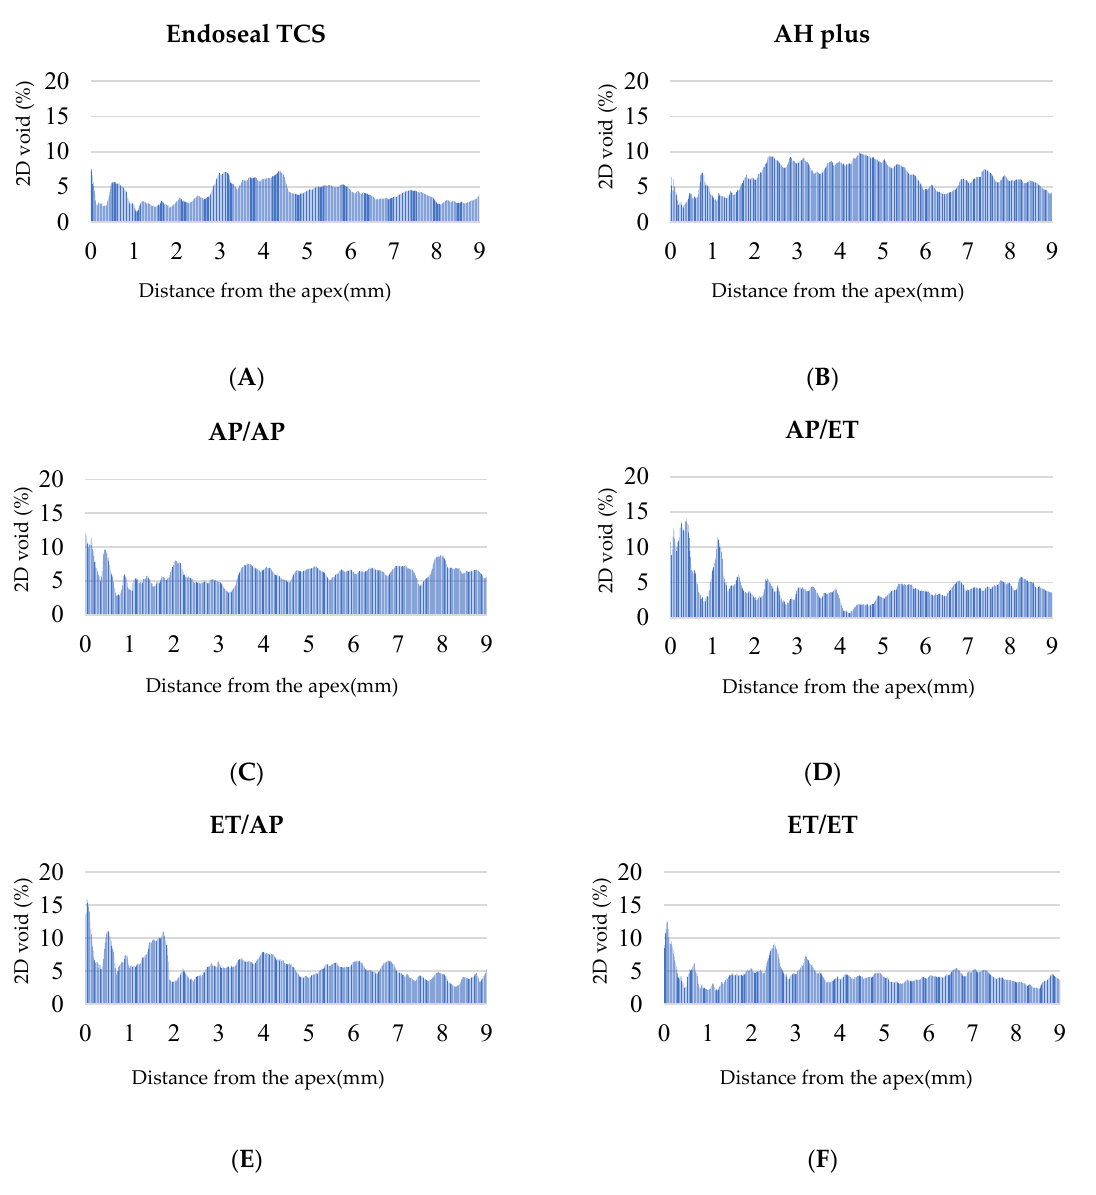
Figure 2. Two-dimensional analysis of void percentage along the distance from the apex. ( A ) Initial obturation of AH plus with CWT; ( B ) initial obturation of Endoseal TCS with SCT; ( C ) re-obturation of AP/AP group, ( D ) re-obturation of AP/ET group; ( E ) re-obturation of ET/AP group; ( F ) re-obturation of ET/ET group.